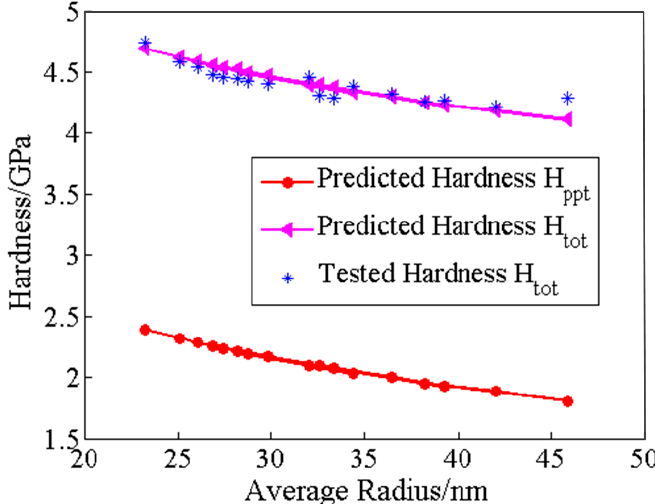
Figure 9. Relation between the nanoindentation hardness H tot , H ppt and the mean radius of tertiary γ’ precipitates.